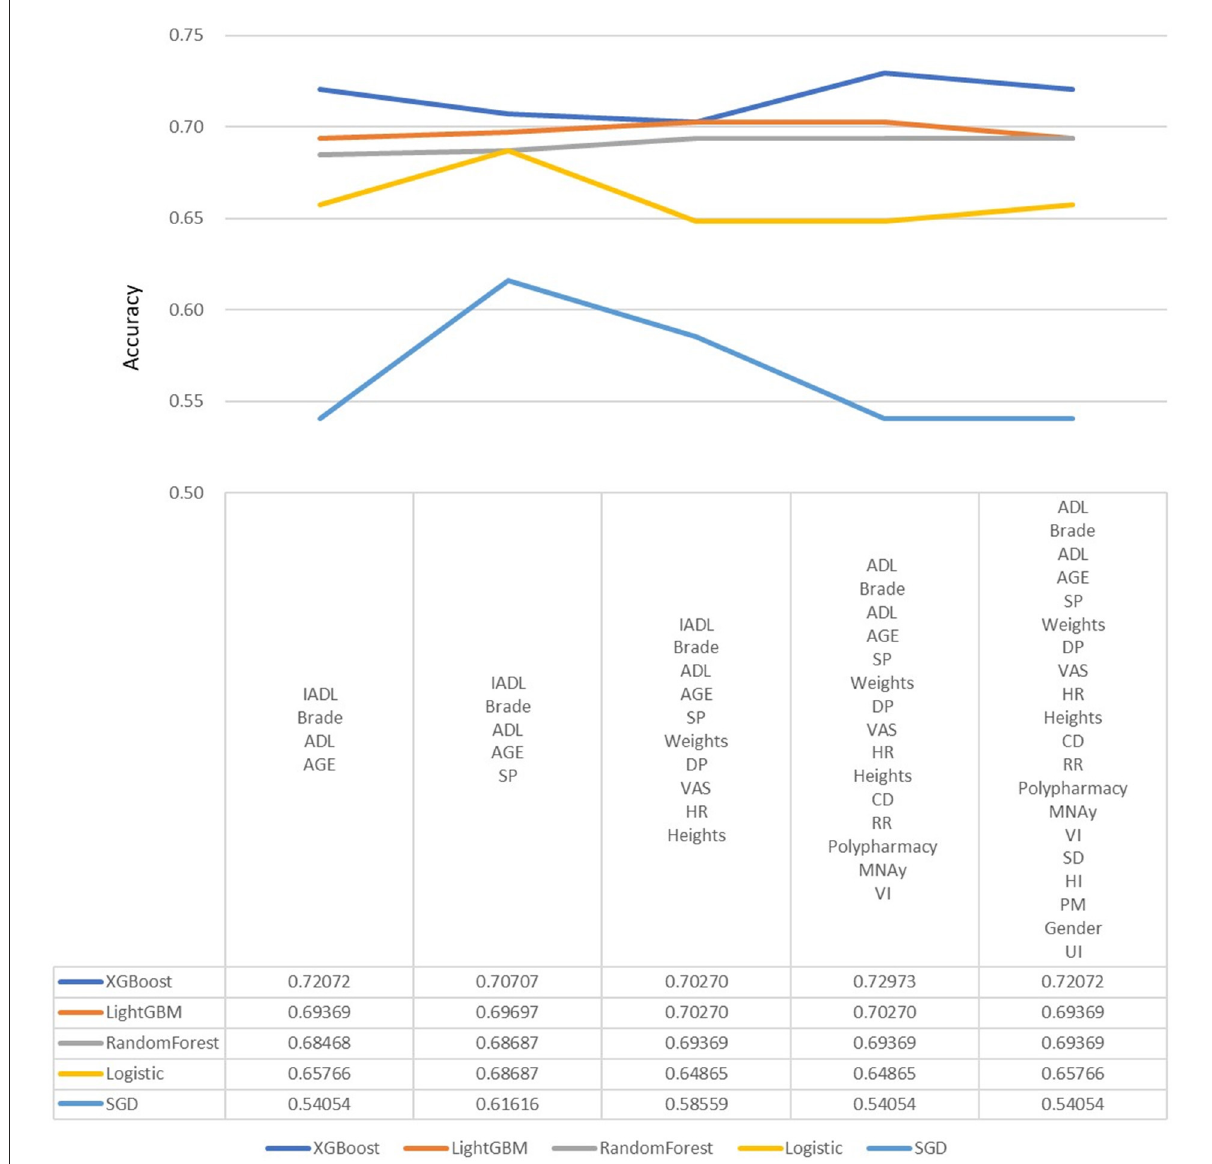
FIGURE2 Predictive accuracy for combined different features in different machine learning models. DP, Diastolic pressure; ADL, Activity of daily living; HR, Heart rate; SP, Systolic pressure; IADL, Instrumental activity of daily living; CHS, Cardiovascular health study; MNA, Mini nutritional assessment; VAS, Visual analog scale; RR, Respiratory rate; CD, Communication disturbance; VI, Visual impairment; SD, Sleep disturbance; HI, Hearing impairment; UI, Urinary incontinence; PM, Psychiatric